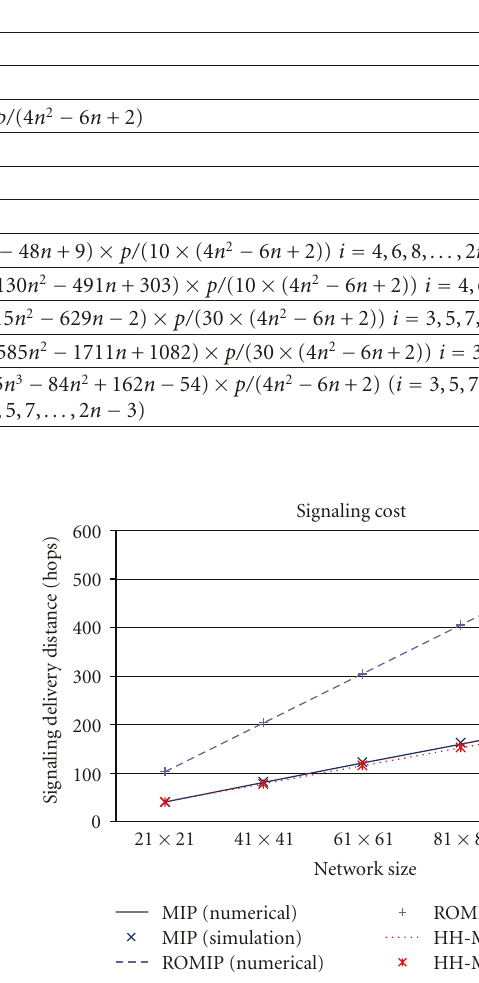
Table 3: Average signaling cost derived by the regions where the THA is located. Region